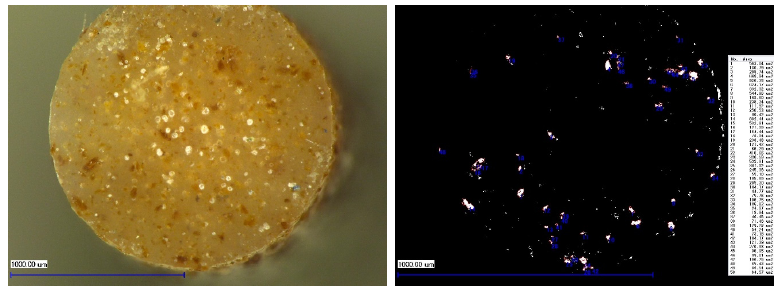
Figure 1. 150× Magnified Top View of Filament ( Left ) and Process Image for Bamboo Powder Size Evaluation ( Right ).